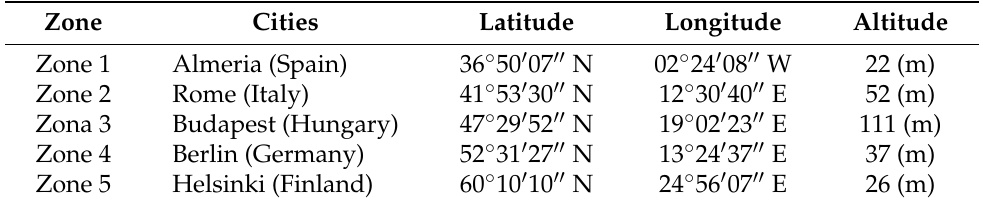
Table 3. Cities under study.